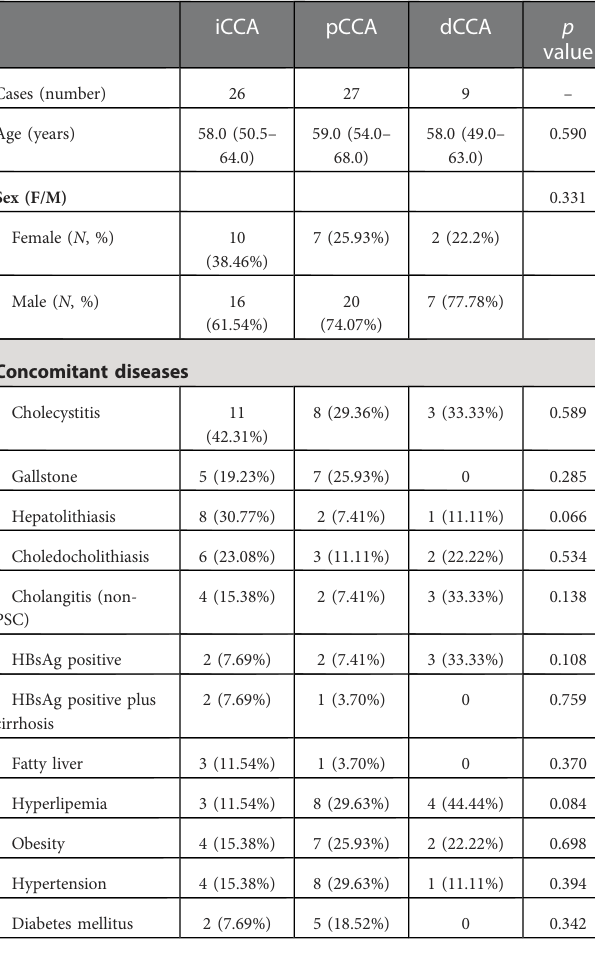
between patients with different subtypes of CCA or after further strati fi cation based on cholelithiasis. In summary, hyperlipemia and cholelithiasis were the main concomitant diseases in pCCA patients.